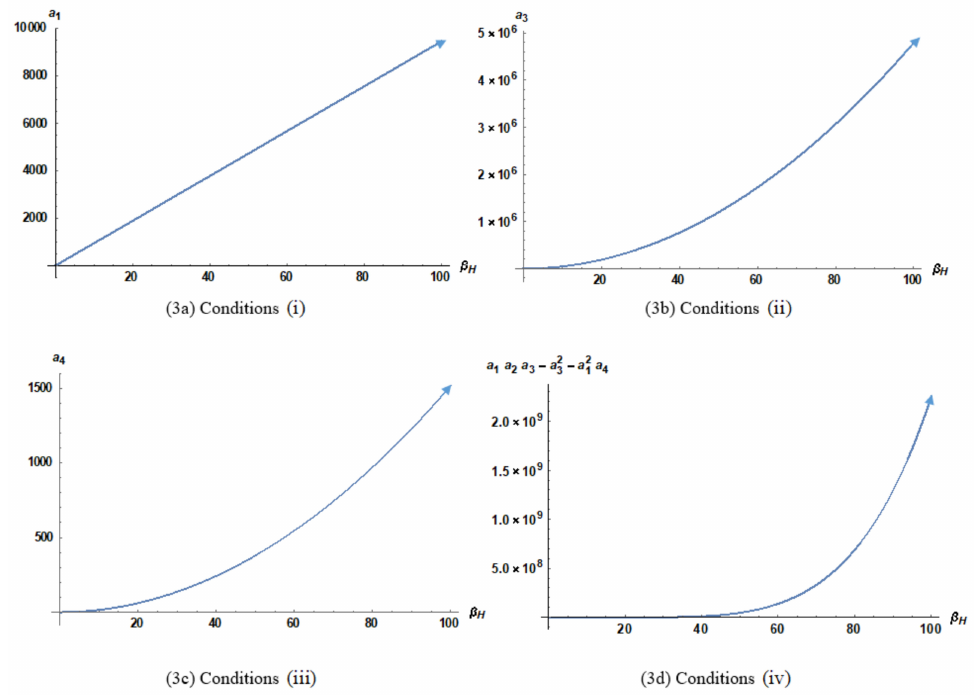
Figure A1. All parameter spaces of endemic equilibrium are satisfied with the Routh–Hurwitz